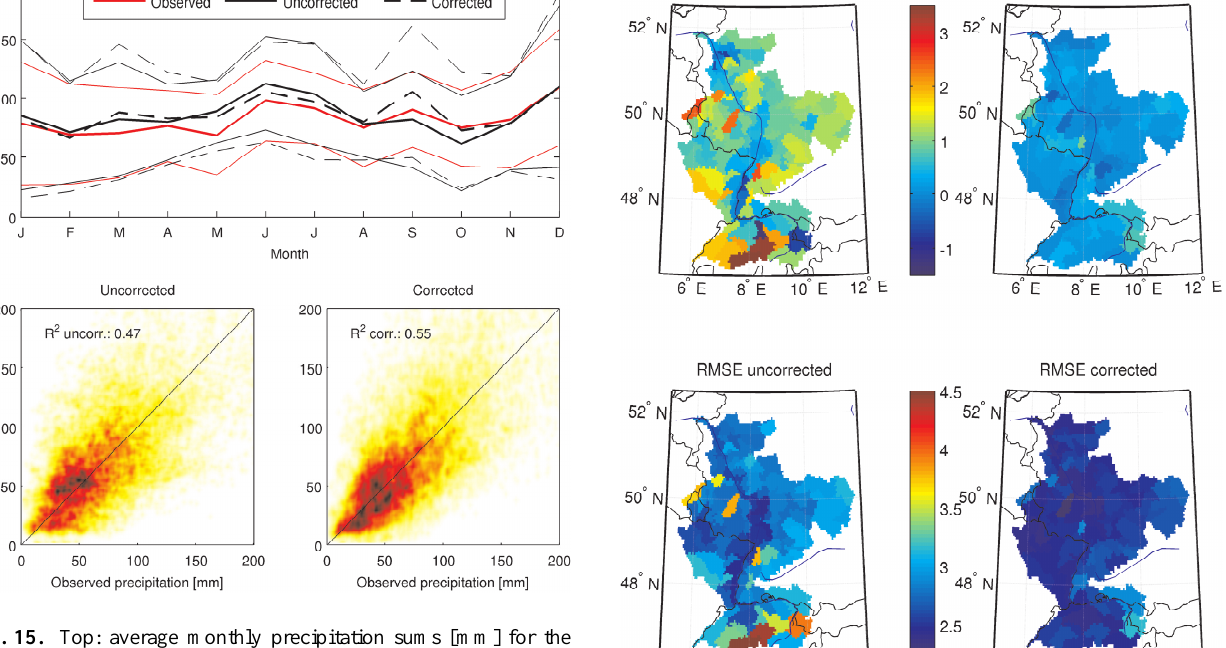
Fig. 15. Top: average monthly precipitation sums [mm] for the observations and the uncorrected and corrected ERA15/REMO data for the validation periond 1989–1995 (solid lines). Average monthly precipitation sums +/- one standard deviation are shown as well (thin lines). Bottom: scatter densities for the uncorrected and corrected ERA15/REMO and observed yearly monthly precipi- tation sums per sub-basin for the validation periond 1989–1995. R 2 coefficients for the uncorrected and corrected situation are shown as well.